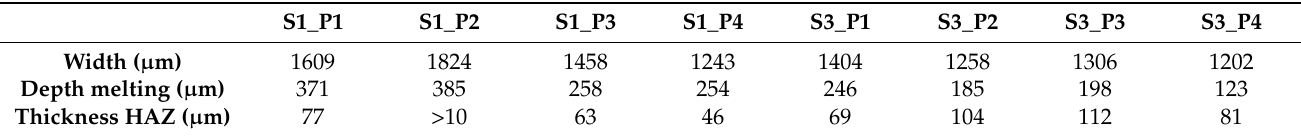
Table 2. Bead measures in different samples (0.2 mm/s